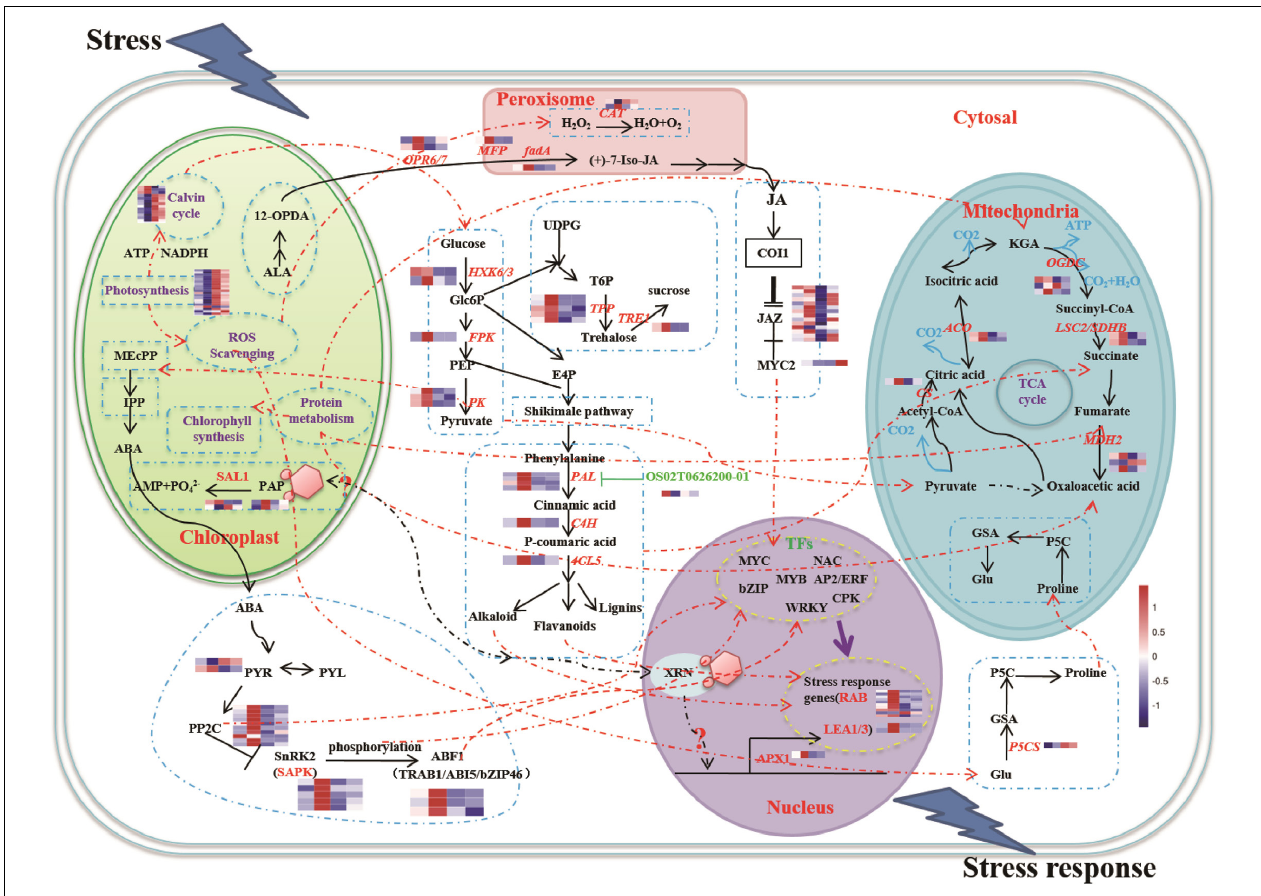
FIGURE 3 | A schematic representation of main processes involved in rice drought memory response. The glycolysis pathway was actived under drought stress, the pyruvate generated was the precursor substance of pigment and signals of chloroplast, which activated upstream genes of ABA signaling. ABA signaling pathway played the central role signals to improve plant drought resistance by active the expression of TFs encoded in the nucleus, genes of energy metabolism in mitochondria, proline synthase and JAZs of JA signaling pathway. Broken lines indicate possible, but not confirmed, routes. Full lines represent the routes have been demonstrated in previous studies. Heatmap of memory transcripts involved in these pathways are